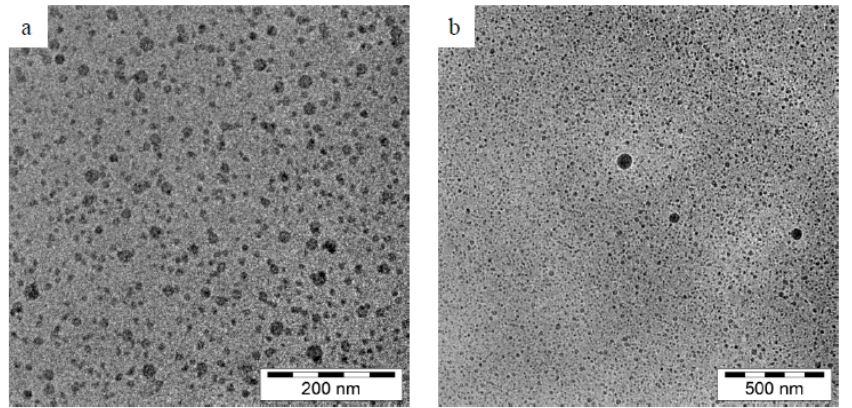
Figure 8. Bioactive cationic nanoemulsion is depicted in two cryo-TEM images: ( a ) at 200 nm and ( b ) at 500 nm [45]. “Reproduced with permission from reference”.